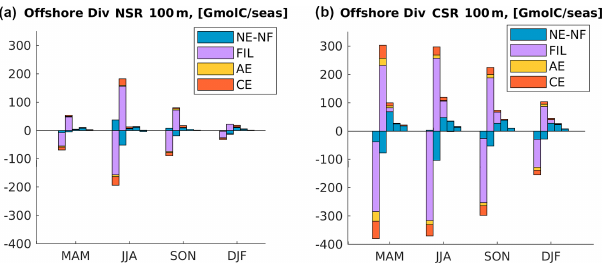
Figure 7. NCP in (a) northern and (b) central CanUS integrated in the first 100m depth and in each offshore region by season. Each group of bars represents a different season. For each season, each one of the five bars represents the difference between the input and the output of offshore flux within two specific offshore boundaries (divergence) or the NCP integrated in the area contained within those two boundaries, i.e., isolines of distance from the coast. From left to right in each group: 0 to 100km offshore, 100 to 500km off- shore, 500 to 1000km offshore, 1000 to 1500km offshore, and 1500 to 2000km offshore. Colors in each bar represent the contribution by a certain type of structure: non-eddy–non-filament (NE–NF), fil- aments (FIL), anticyclones (AEs), and cyclones (CEs). Positive and negative contributions to the flux through each boundary are plotted separately in order to make them clearly visible.